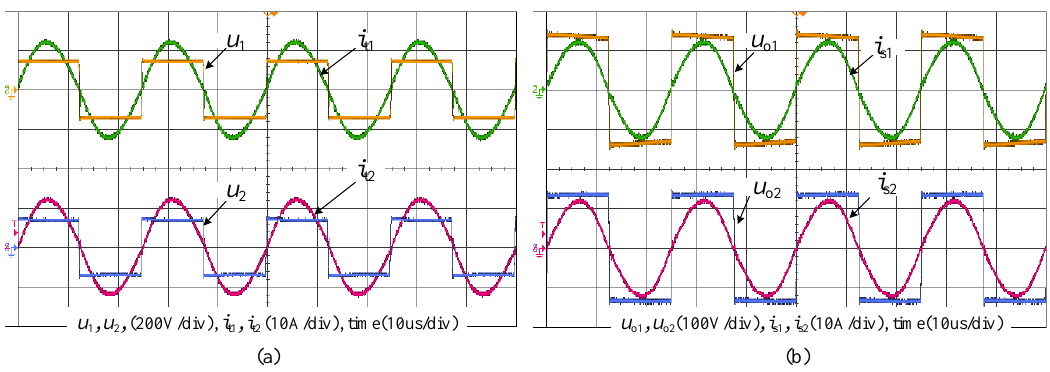
Figure 10. Experimental results: ( a ) waveforms of primary inverters output; ( b ) waveforms of secondary rectifiers input.